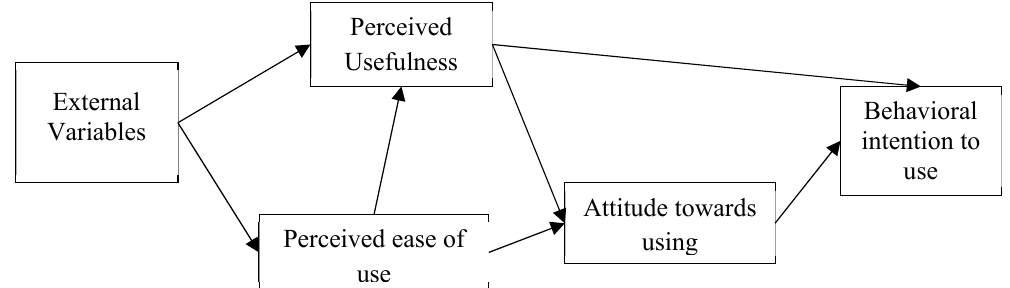
Fig. 1. Original technology acceptance model (TAM) (adopted from Davis,